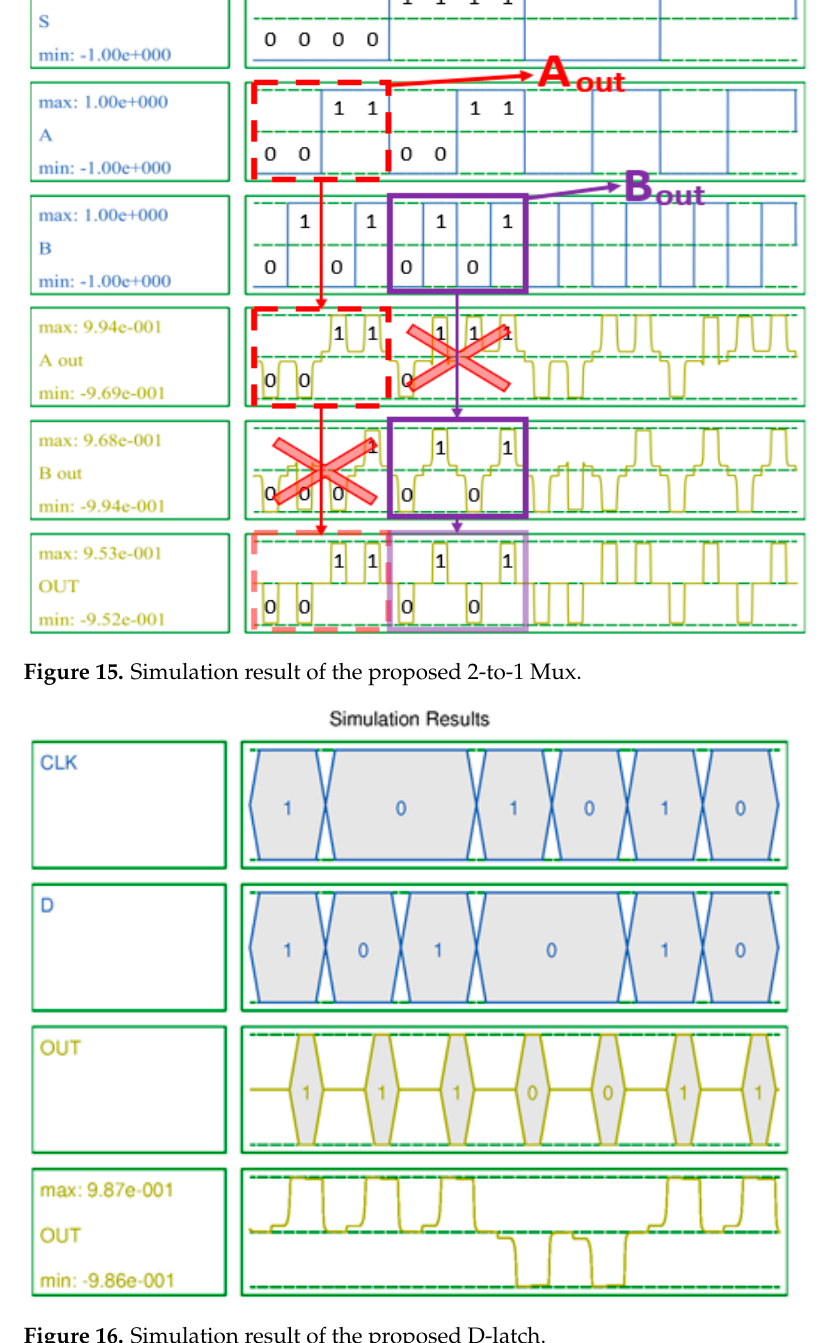
Figure 16. Simulation result of the proposed D-latch.